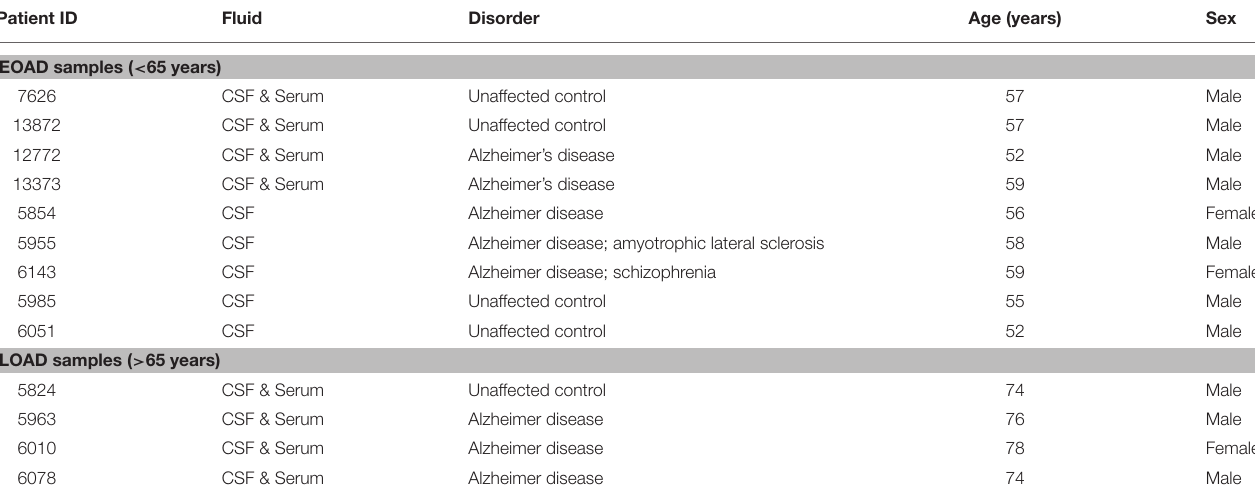
TABLE 3 | Postmortem human AD and age matched unaffected control patient sample